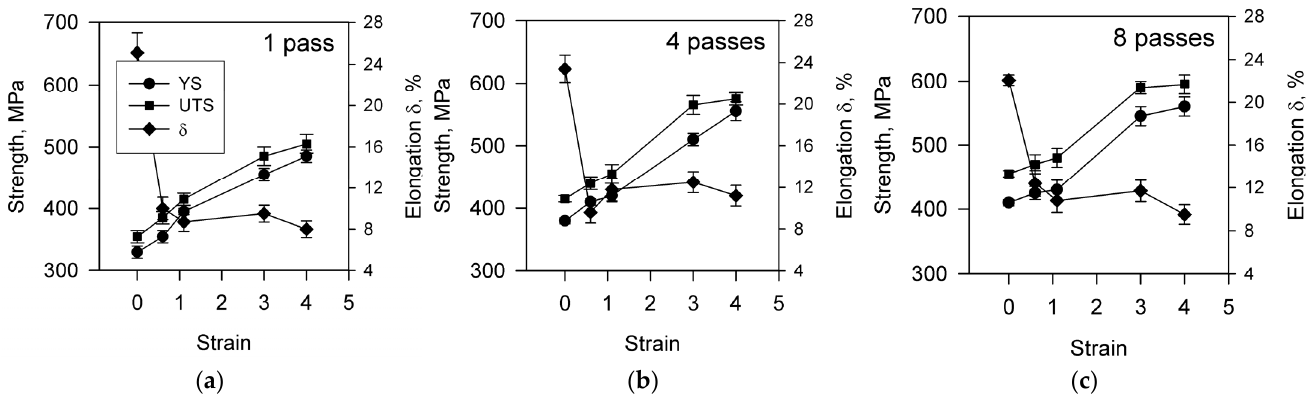
Figure 6. Changing the yield strength (YS), the ultimate tensile strength (UTS), and elongation ( δ ) of a Cu-Cr-Zr alloy after cold rolling to different strains following by 1 ( a ), 4 ( b ), and 8 ( c ) passes of ECAE-Conform.